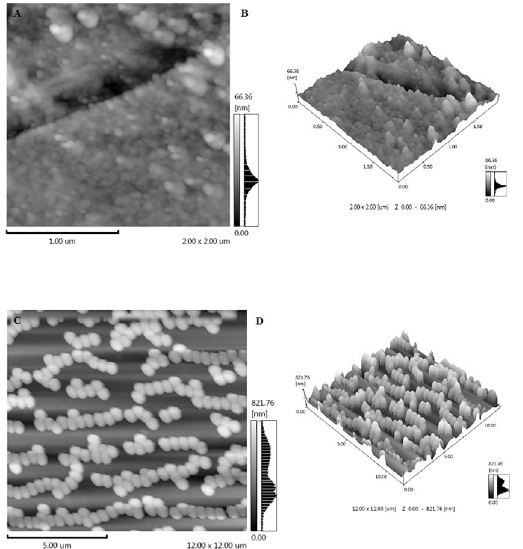
Figure 5. AFM characterization of latex beads films: (A) - bare substrate (surface profile); (B) - bare substrate (3-dimension profile);